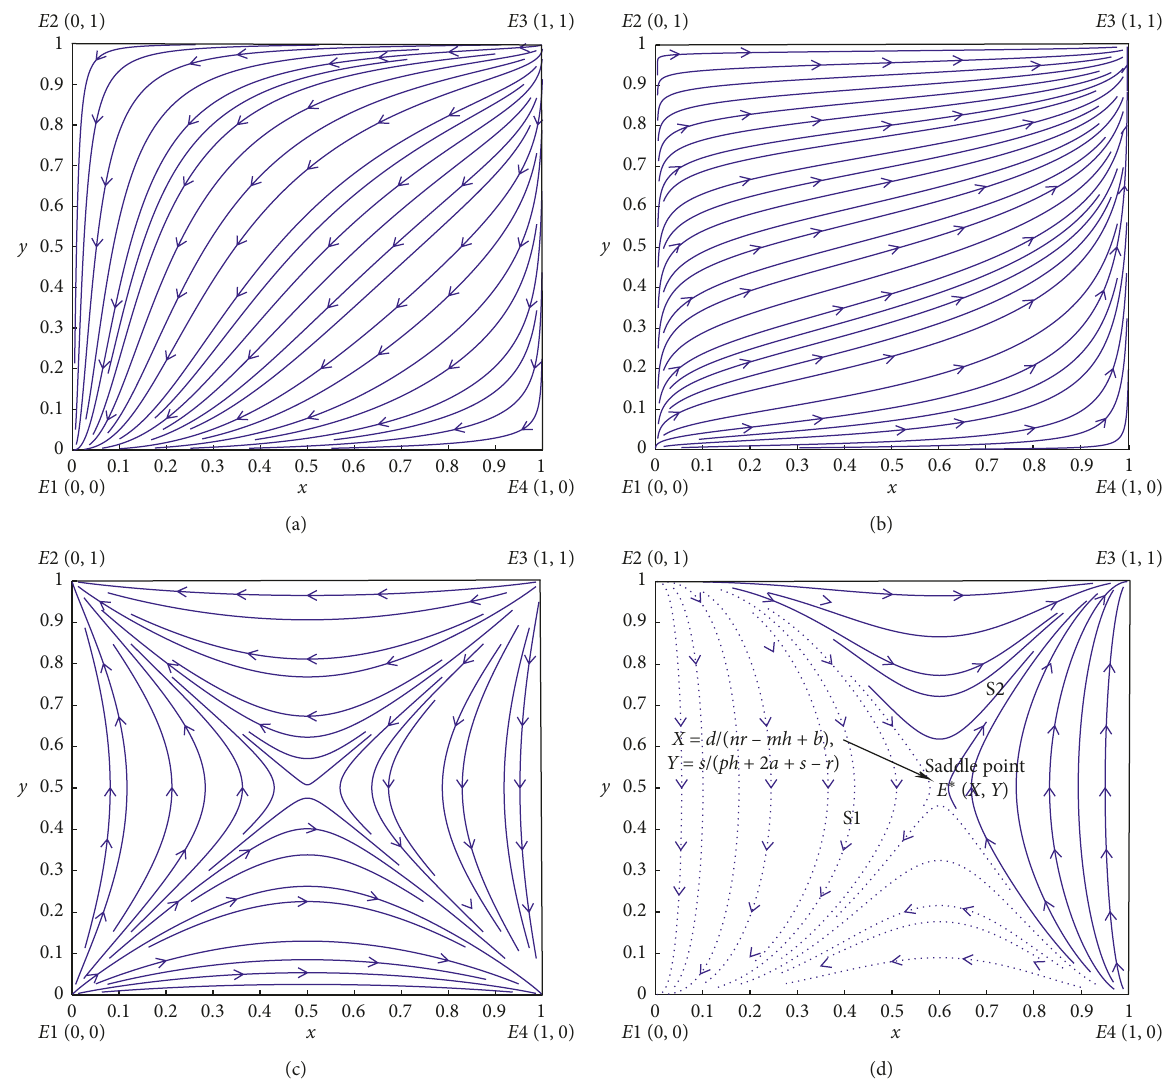
Figure 2: Evolution phase diagram of States (a) 1, (b) 2, (c) 3, and (d)